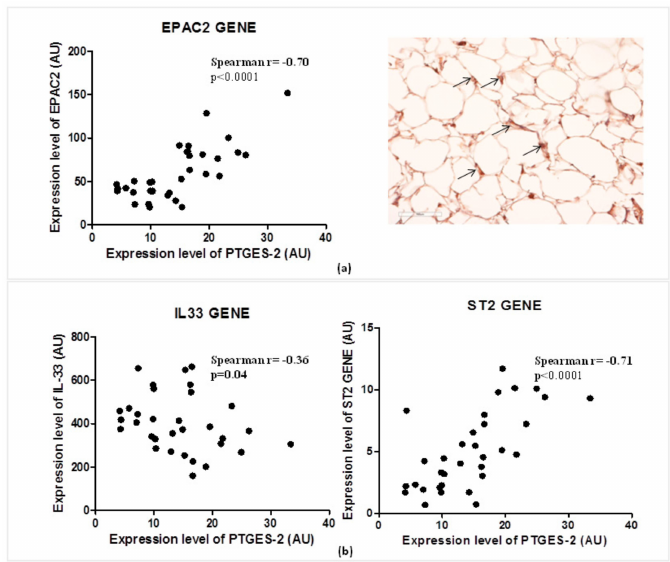
Figure 3. PTGES-2 gene directly correlates with EPAC2 inducer of ST2 / IL-33 mechanosensitive system in overweight CVD patients. ( a ) The expression level of PTGES-2 directly correlates with the local expression gene of EPAC2 cAMP e ff ector, powerful inducer of ST2 / IL33 mechanosensitive system in immune cells. The local immunolocalization of EPAC2 cAMP e ff ector in EAT biopsies of overweight CVD subjects is demonstrated by EPAC2 + cells in the stroma region (black arrows; magnification 20 × ). ( b ) The PTGES-2 controller of cAMP e ff ectors directly correlates with ST2 / IL-33 mechanosensitive genes associated with fat and cardiac